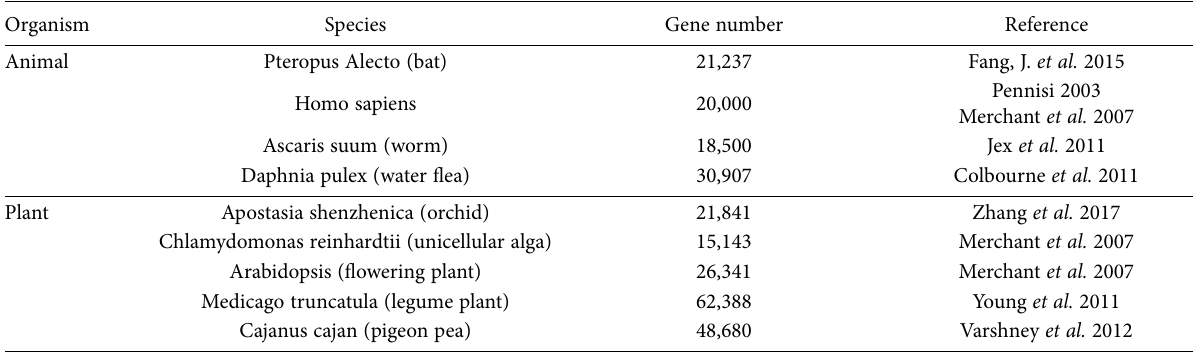
Table 3. Number of protein-coding genes in animals and plants. Organism Species Gene number Animal